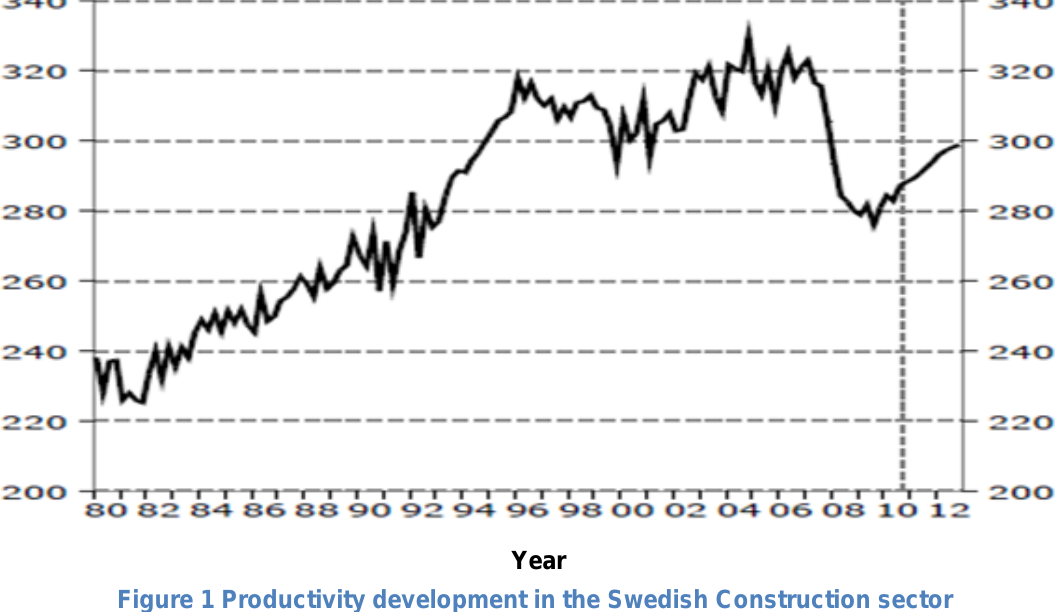
Figure 1 Productivity development in the Swedish Construction